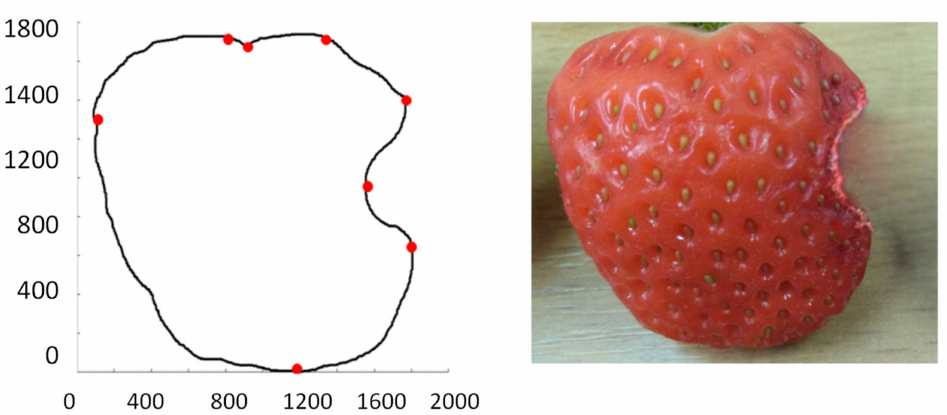
Figure 7. A fruit demaged on the inside. Its contour is described by the sinquad 14.41.14.43.34.43.32.21.